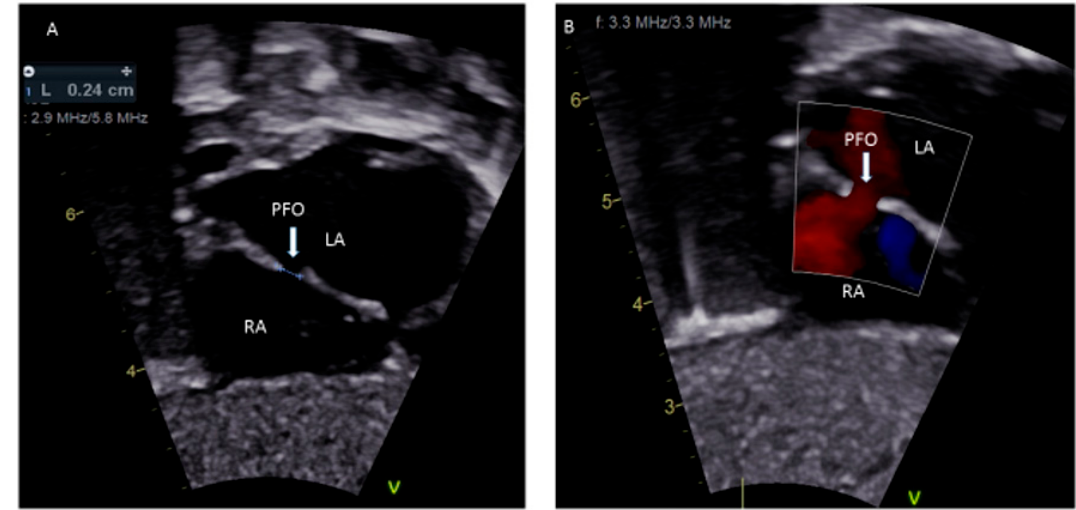
Figure1. ( A )Sub-costalviewshowinga2.4mmPFO;( B Figure 1. ( A ) Sub-costal view showing a 2.4 mm PFO; ( B ) Color Doppler demonstrating left to right shunting.